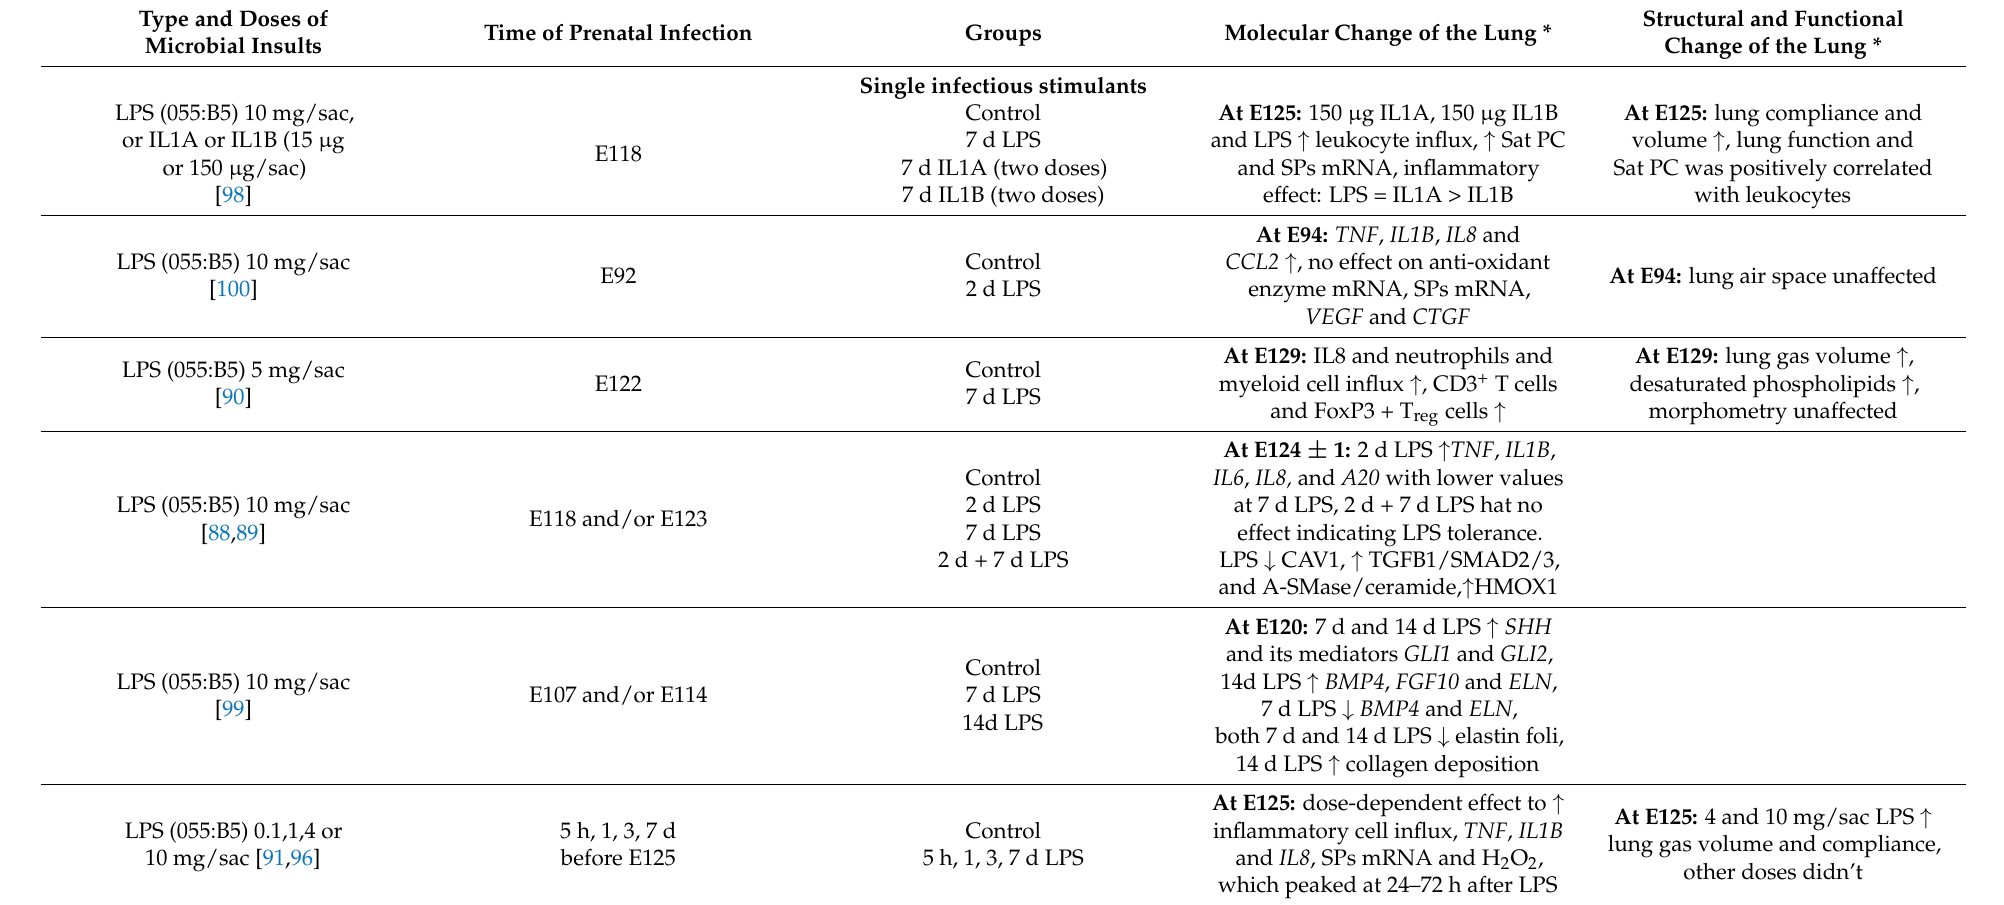
Table 2. Representative sheep models of prenatal infection and pulmonary